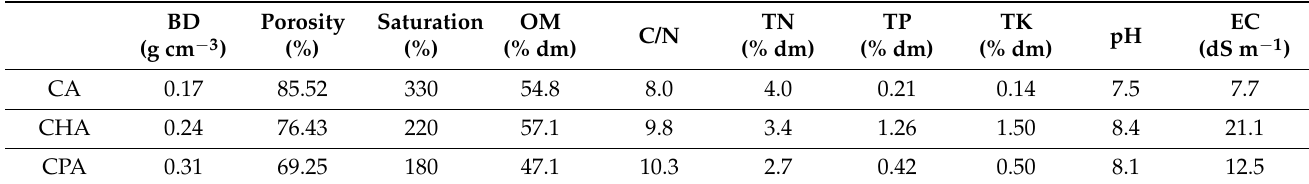
Table 2. Physiochemical characteristics of CA ( R. okamurae ), CHA (two-thirds horticultural green residues and one-third R. okamurae ), and CPA (two-thirds garden pruning residues and one-third R. okamurae